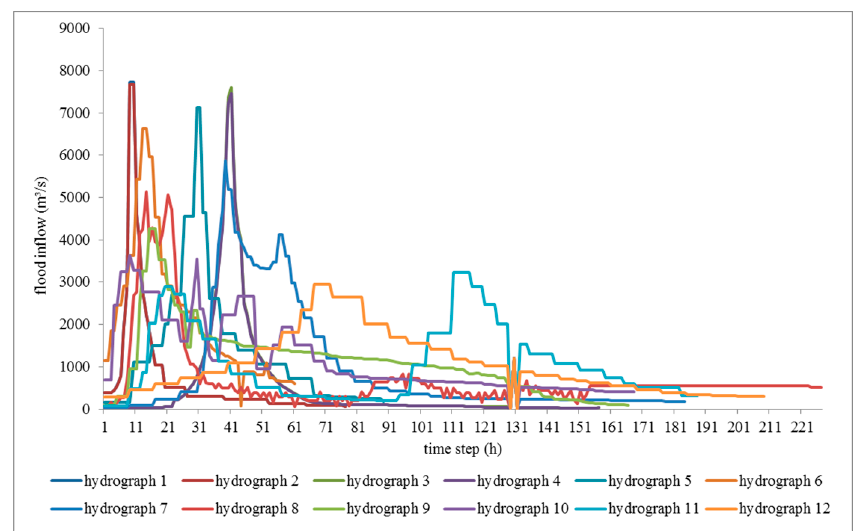
Figure 13. Simulated hydrographs of C and scenario.